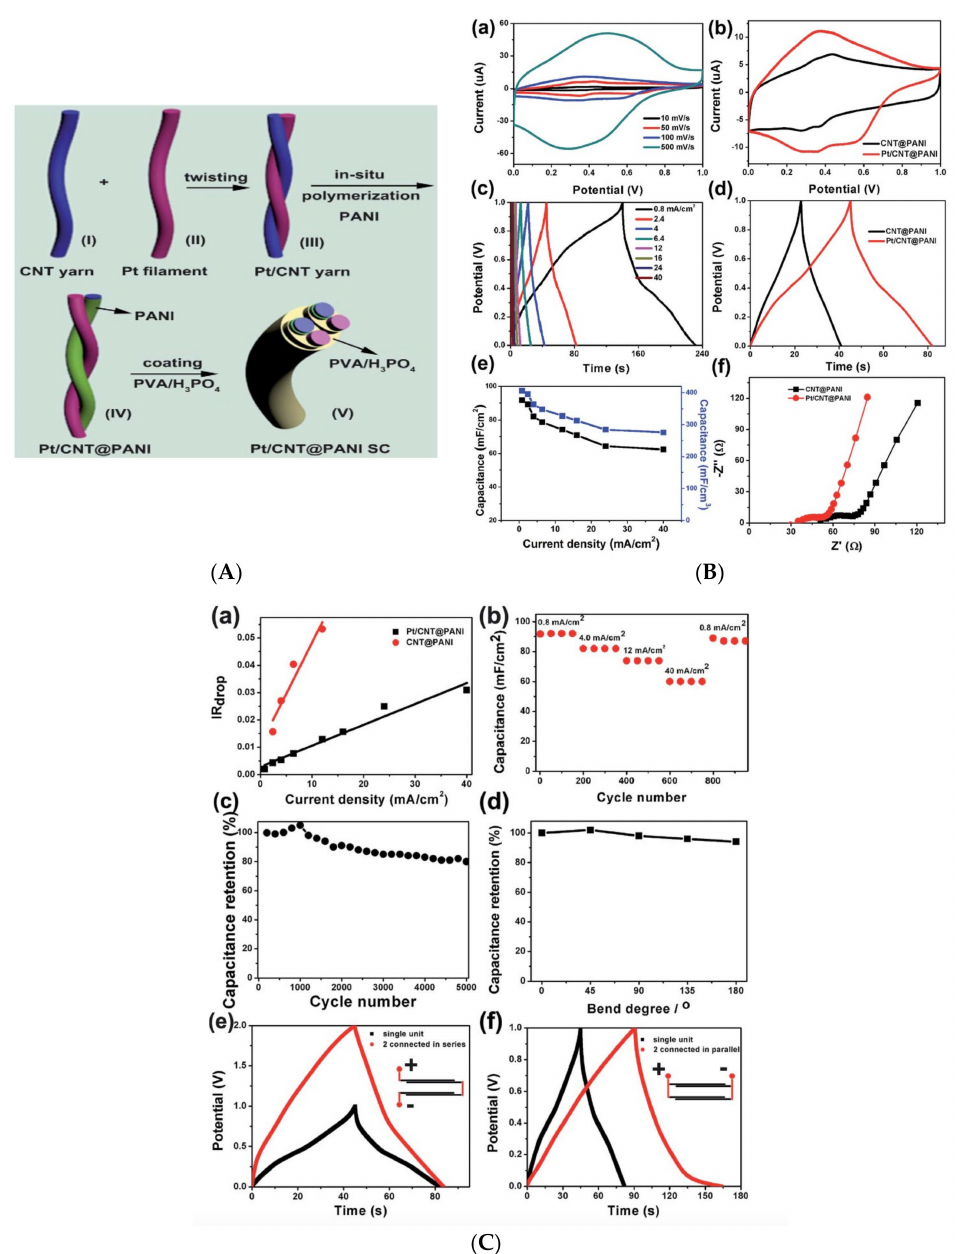
Figure 9. ( A ) Schematic of the fabrication of SCs. ( B ) The electrochemical properties of two-ply nanocomposite yarn SCs: ( a ) CV of the Pt/CNT@PANI yarn SC; ( b ) CV curves of CNT@PANI and Pt/CNT@PANI yarn SCs at 100 mV · s − 1 ; ( c ) galvanostatic charge–discharge (GCD) curves of the Pt/CNT@PANI yarn SC at different current densities; ( d ) GCD curves of CNT@PANI and Pt/CNT@PANI SCs at 2.4 mA/cm 2 ; ( e ) areal capacitance of the Pt/CNT@PANI yarn SC at different current densities; ( f ) EIS of CNT@PANI and Pt/CNT@PANI SC devices. ( C ) Characterization of the Pt/CNT@PANI nanocomposite yarn supercapacitor: ( a ) IR loss (drop of the cell internal resistance) as a function of the discharge current density; ( b ) cycle performance at varying current densities; ( c ) capacitance retention with different charging–discharging cycles and a constant current density of 4 mA/cm 2 ; ( d ) capacitance retention under different bending states; ( e ) GCD of two devices connected in series and ( f ) in parallel. Reproduced with permission from